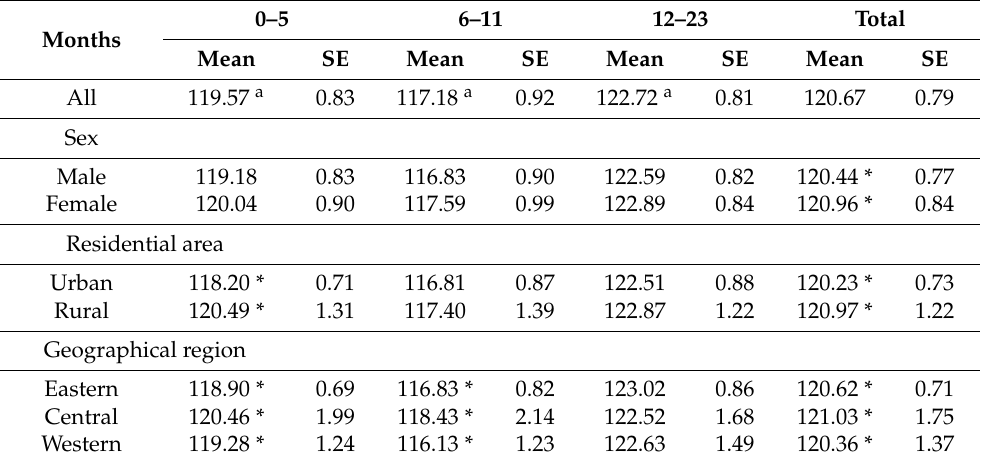
Table 2. Haemoglobin status of infants stratified by sex, residential area and geographical region.